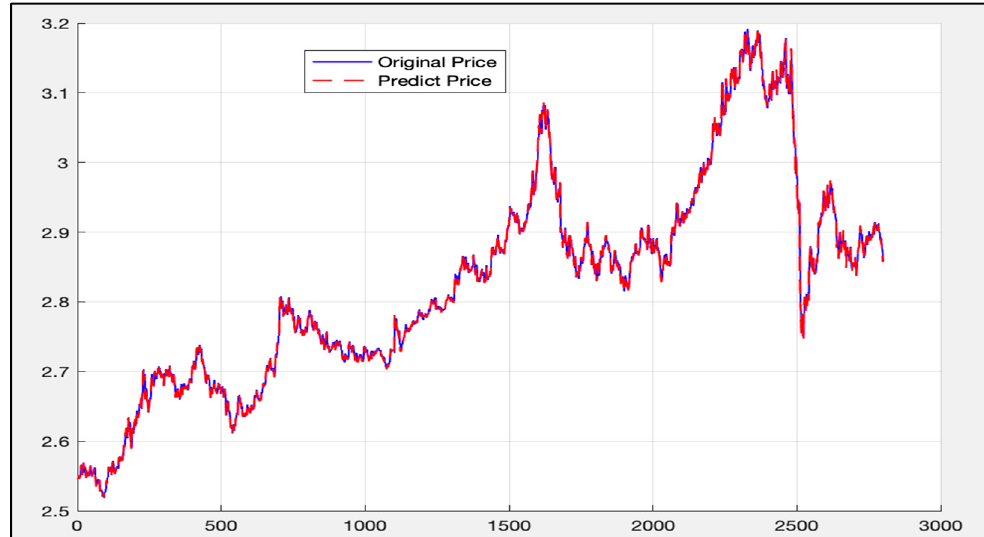
Figure 21. Comparison of LSTM-SVR I prediction results with actual results (8500th data to 11,300th data).